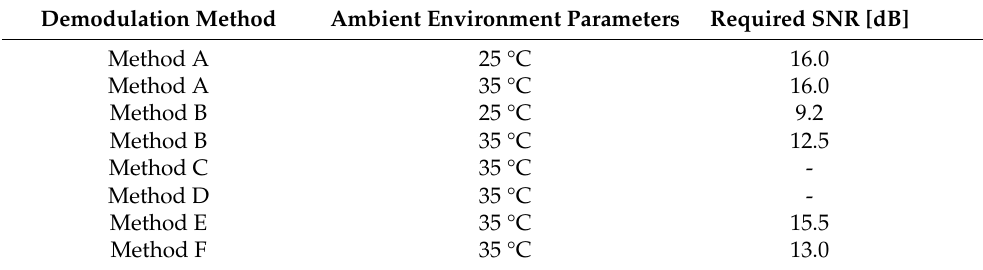
Table 4. Required SNR in homogeneous temperature distribution.